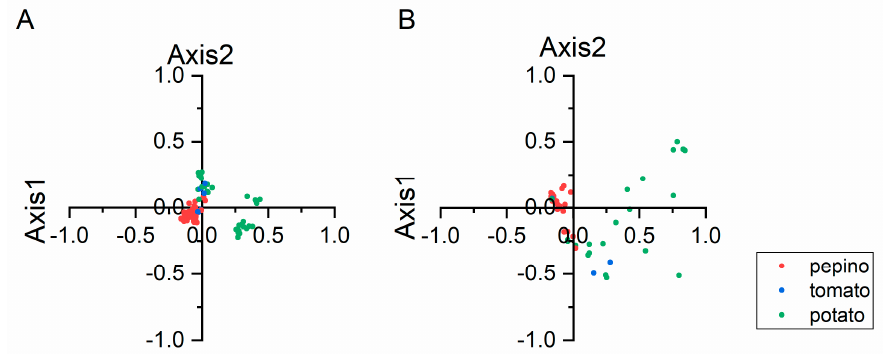
Figure 3. PCA based on the RSCU values of the 59 synonymous codons the CP ( A ) and NABP ( B ) genes of PVM. The pepino, potato and tomato hosts are represented in red, green and blue, respectively.